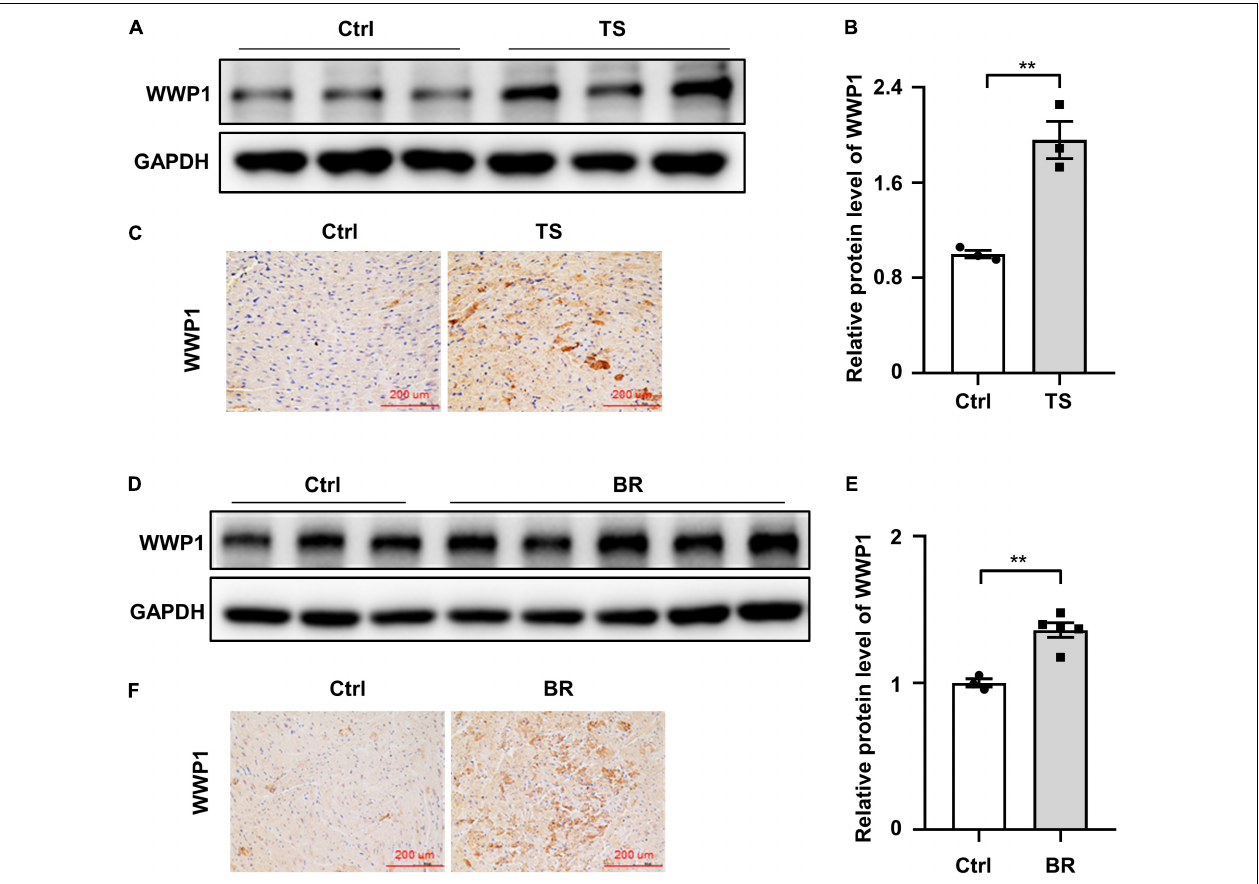
FIGURE 1 | WW domain-containing E3 ubiquitin protein ligase 1 expression changes in the hearts of mice and rhesus monkeys after simulated microgravity. (A) Representative western blotting analysis of WWP1 expression in cardiac extracts of adult mice following tail suspension (TS) for 6 weeks ( n = 3 for each group). (B) Quantification of WWP1 protein levels of (A) . (C) Immunohistochemistry for WWP1 (brown) in paraffin section from mouse hearts at 6 weeks after tail suspension. Scale bars, 200 µ m. (D) Representative western blotting analysis of WWP1 expression in cardiac extracts of adult rhesus monkeys following bed rest (BR) for 6 weeks (Ctrl, n = 3; BR, n = 5). (E) Quantification of WWP1 protein levels of (D) . (F) Immunohistochemistry for WWP1 (brown) in paraffin section from rhesus monkey hearts at 6 weeks after bed rest. Scale bars, 200 µ m. Data represent the means ± SEM. * P < 0.05, ** P < 0.01. WWP1, WW domain-containing E3 ubiquitin protein ligase 1; TS, tail suspension; BR, bed